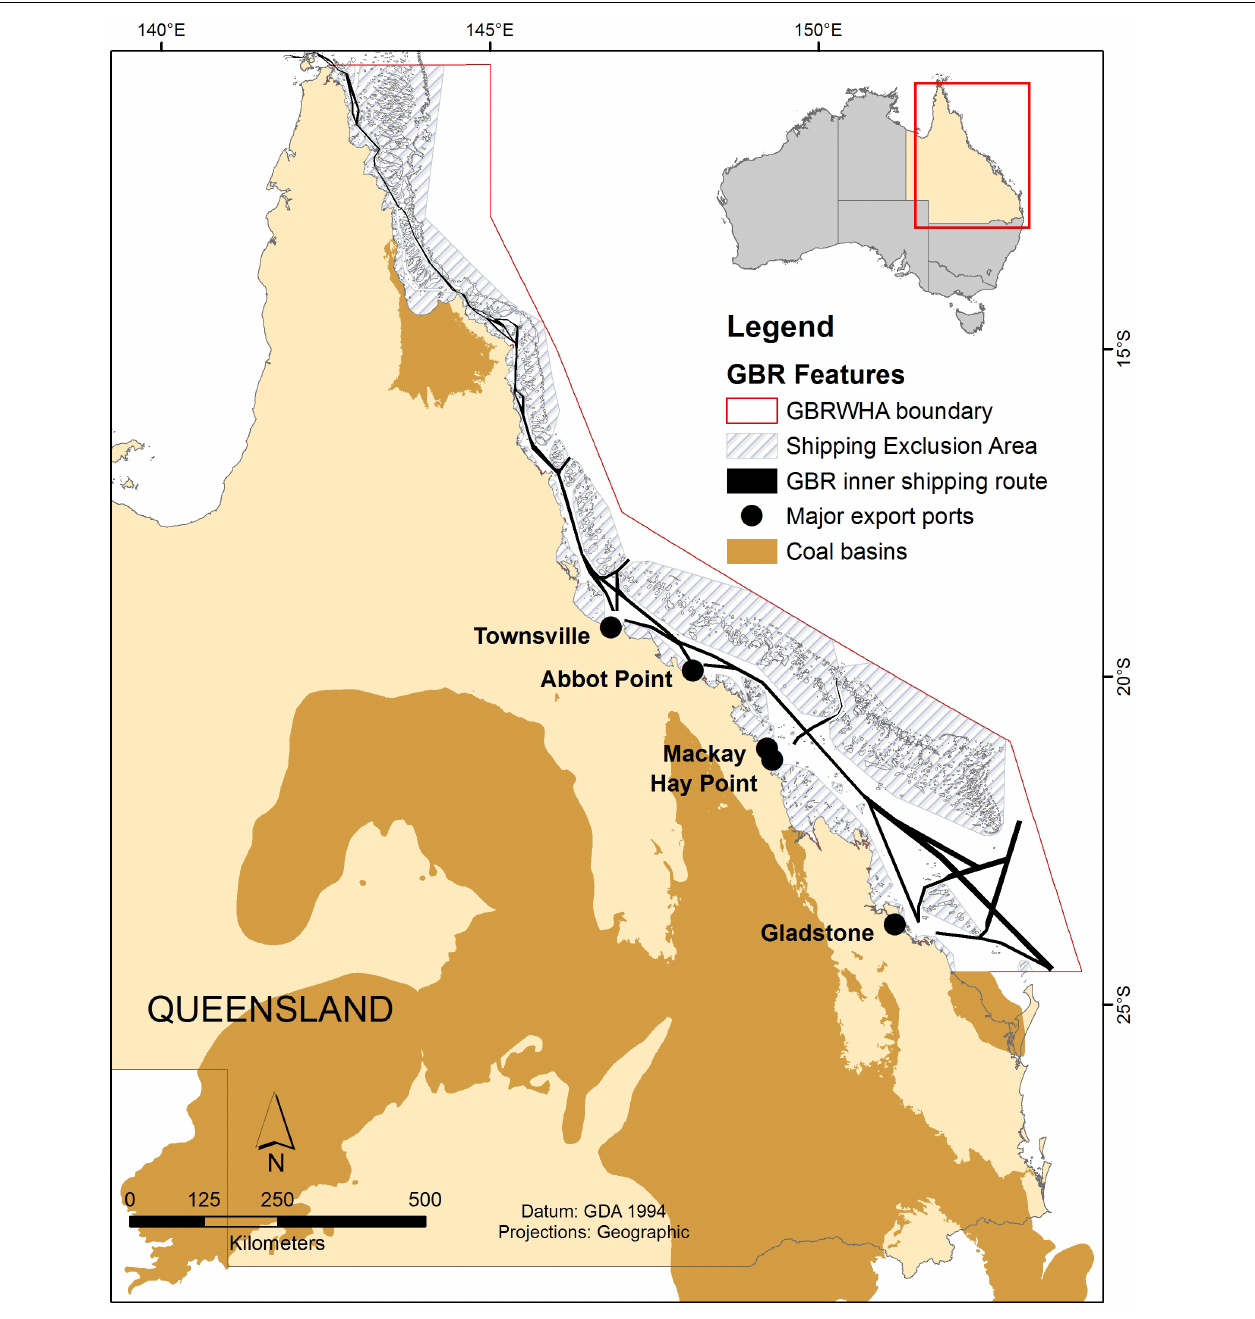
FIGURE 1 | Spatial extents of coal basins, locations of major coal export ports in the State of Queensland, and two-way inner shipping route within the Great Barrier Reef World Heritage